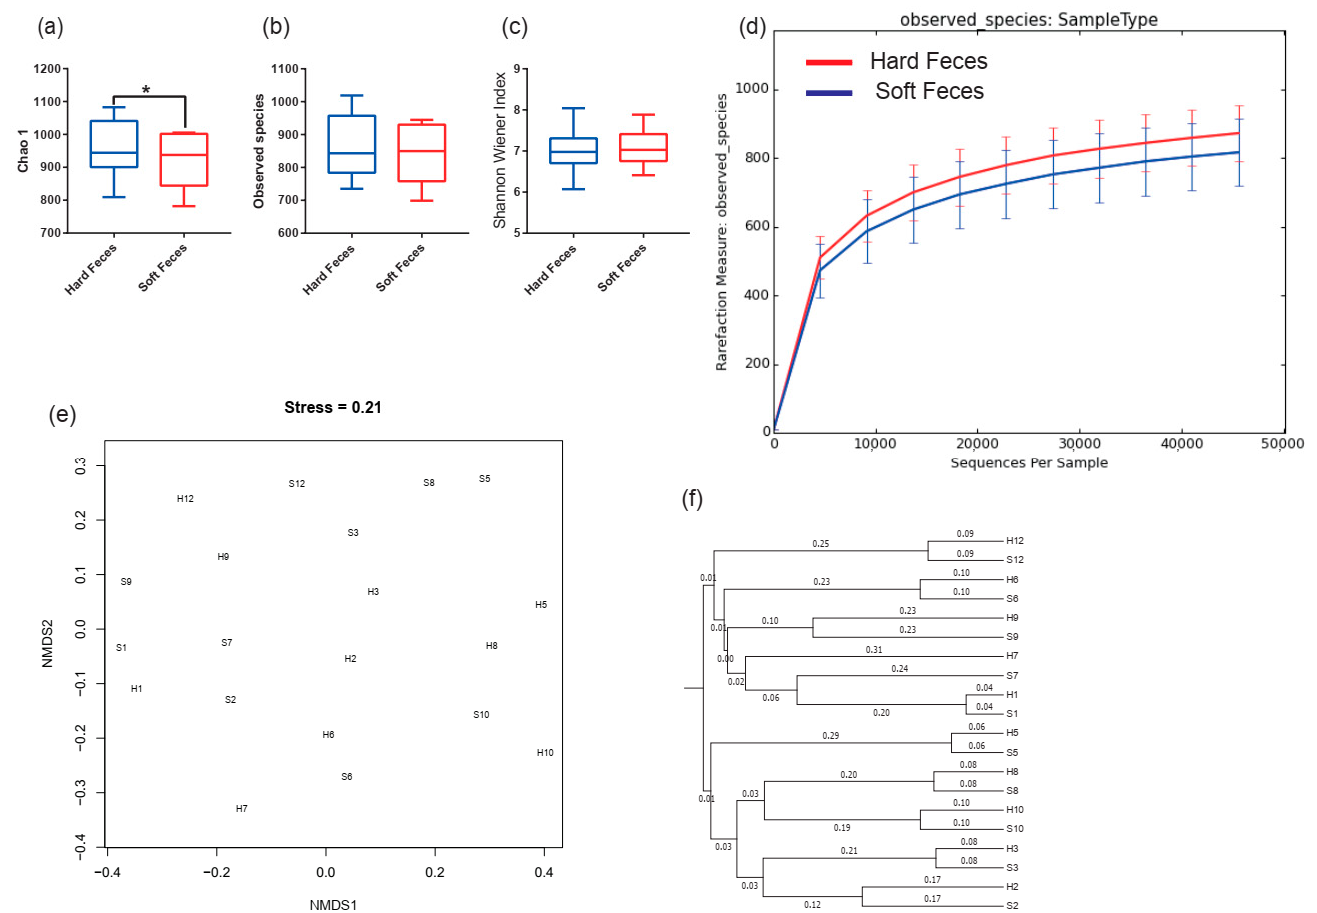
Figure 2. Composition of gut microbiota of hard feces and soft feces in plateau pikas. ( a ) Relative